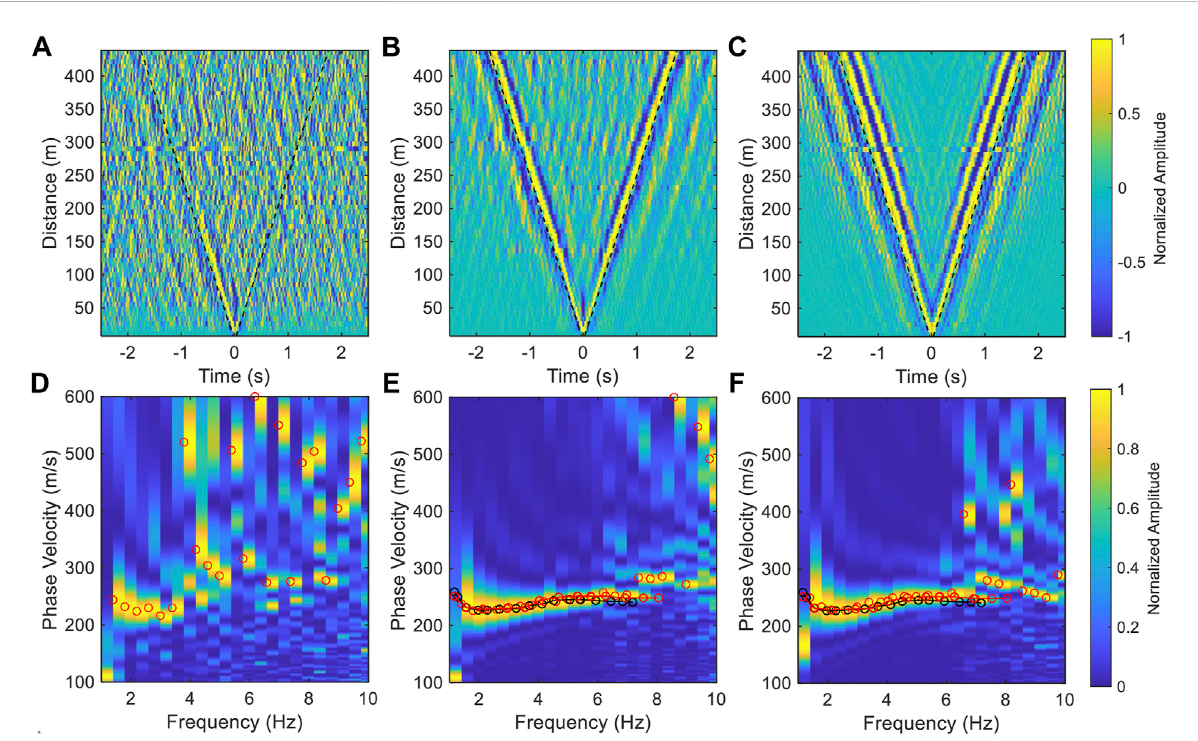
FIGURE 8 Speed-up convergence of NCF via the TSI. (A,B) are the common virtual-shot gather of segment 4 calculated with 30-s and 4-h data, respectively. (C) is the denoised result of (A) , and the negative lag of (C) is symmetric to its positive lag. The black dashed lines represent a velocity of 250 m/s. (D – F) are the dispersion spectra of (A – C) , respectively. The red and black lines are the picked dispersion curves of (E,F) ,